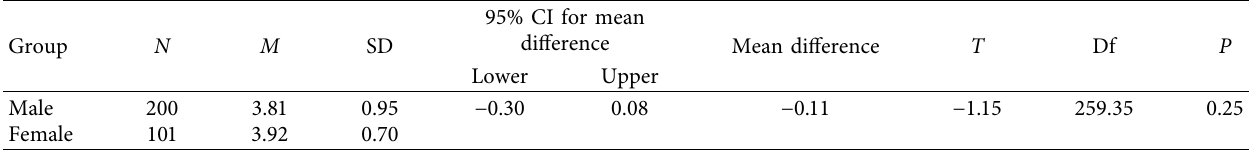
Table 6: t -test results for SDLR between male and female civil